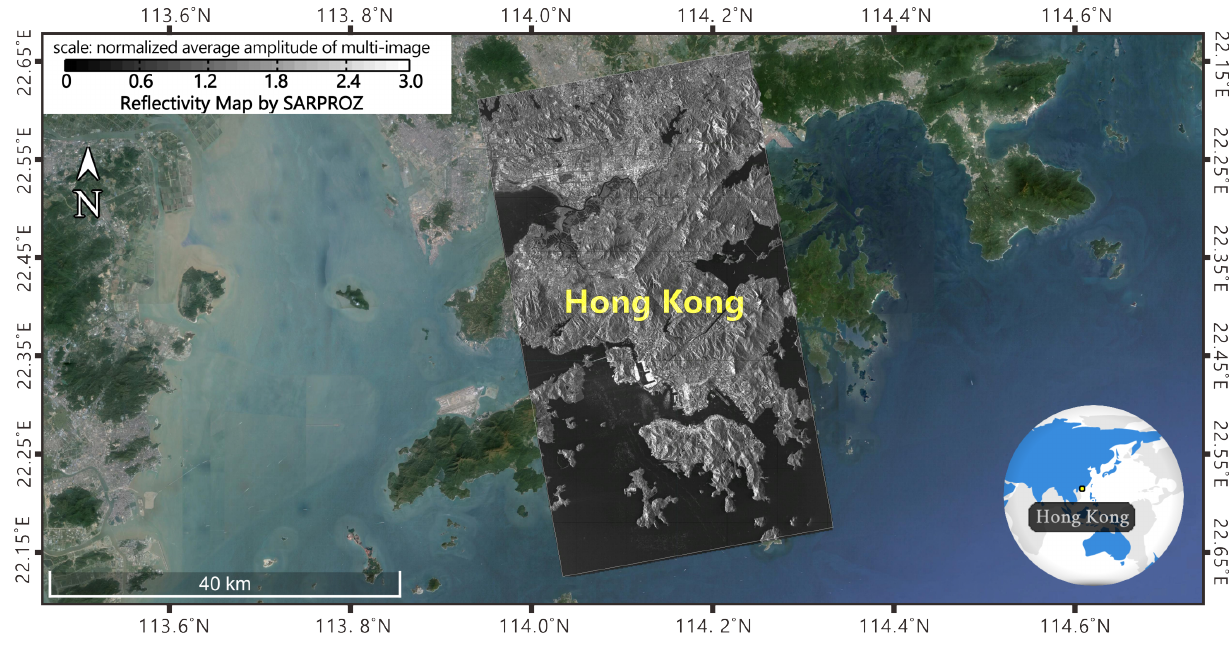
Figure 6. The reflectivity map for one whole frame of the TSX/TDX dataset.